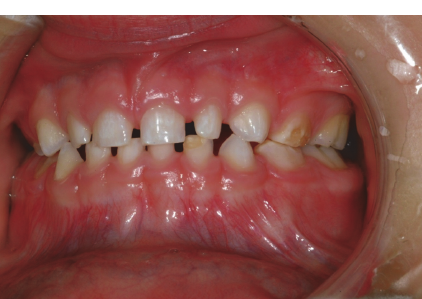
Figure 3: Photograph showing the enamel hypomineralization affecting the labial surface of the upper anterior teeth, hypoplasia in 72, and hypomineralization in 64 and